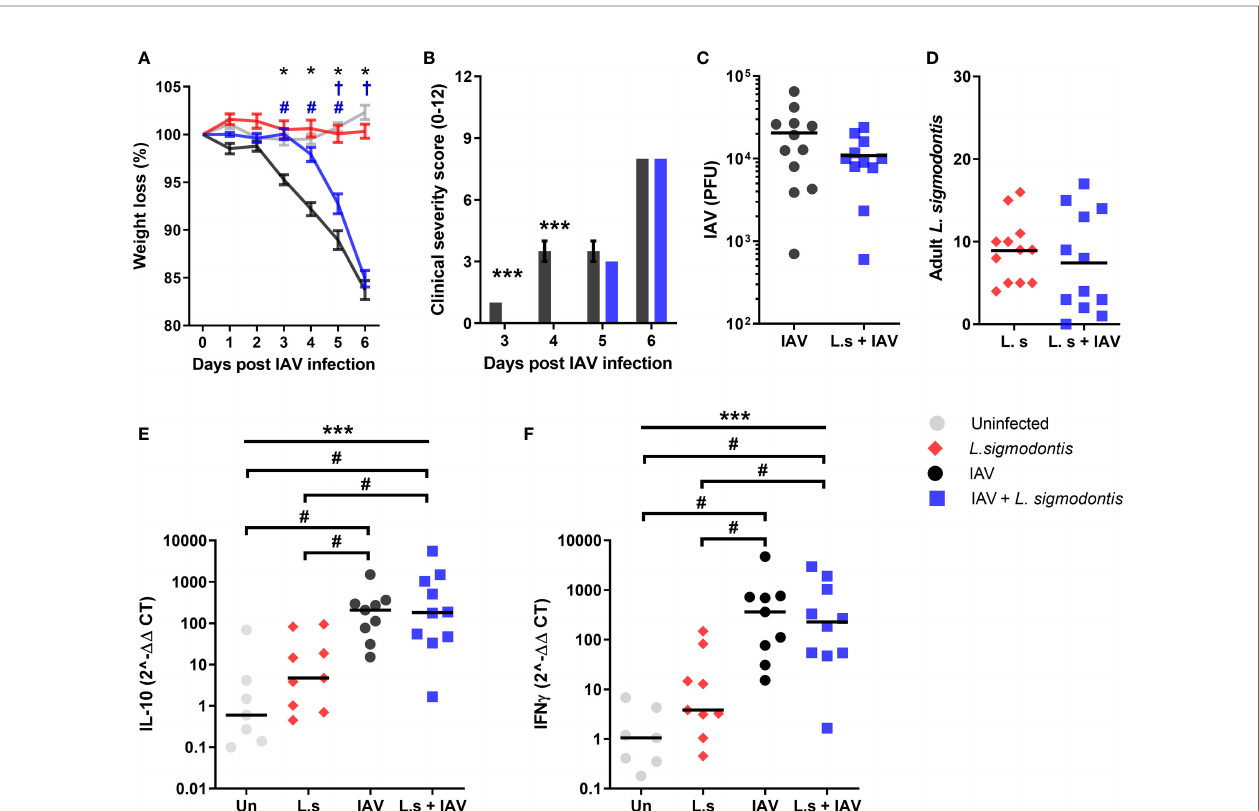
FIGURE 2 | Juvenile adult stage of L. sigmodontis infection delays weight loss and progression of in fl uenza A clinical signs. All panels show combined data from two independent experiments, uninfected n=8, IAV n=12, L. sigmodontis n=12, IAV + L. sigmodontis n=12. (A) Weight loss over time (d post IAV infection). Displayed as mean ± SEM. ***signi fi cant effect between groups dependent upon time point, p < 0.001 (GLM). *p < 0.05 signi fi cant effect between IAV and uninfected group (Tukey ’ s HSD). # p < 0.05 signi fi cant effect between IAV infected and coinfected group (Tukey ’ s HSD). † p < 0.05 signi fi cant effect between uninfected and coinfected group, (Tukey ’ s HSD). (B) Combined clinical severity score. Median ± MAD shown, ***p < 0.001 (Mann Whitney U test). (C) IAV titre (PFU) in lung homogenates 6 d post IAV infection. Mean and individual mice shown. (D) Numbers of adult L. sigmodontis recovered from the pleural cavity 6 d post IAV infection. Median and individual mice shown. (E, F) Levels of IL-10 (E) and IFN- g (F) mRNA in lung tissue, normalised to 18s RNA expression (n=7-12). Mean and individual mice shown. ***Signi fi cant effect between groups (p < 0.001, ANOVA), # p < 0.05 (Tukey ’ s